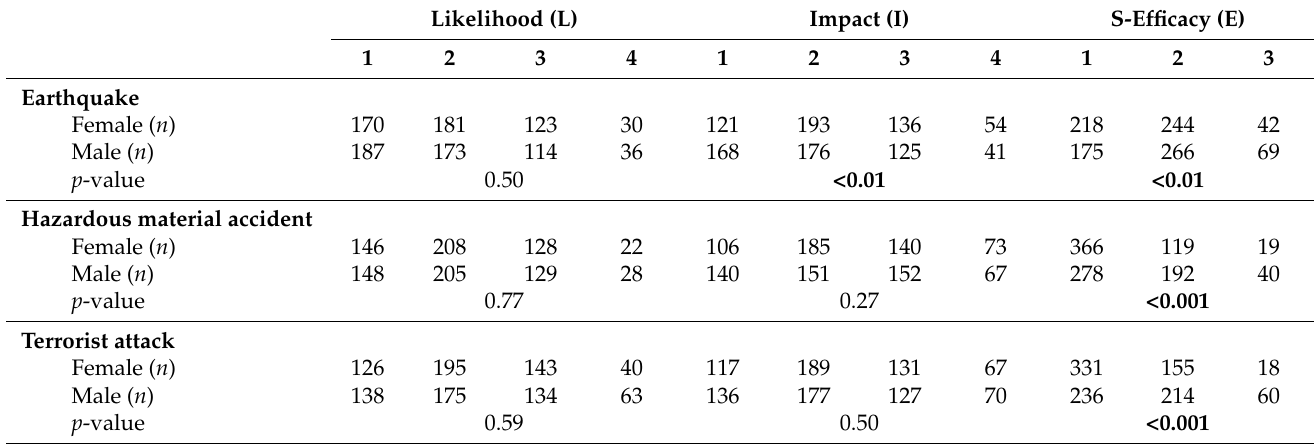
Table 4. Cont. Likelihood (L)